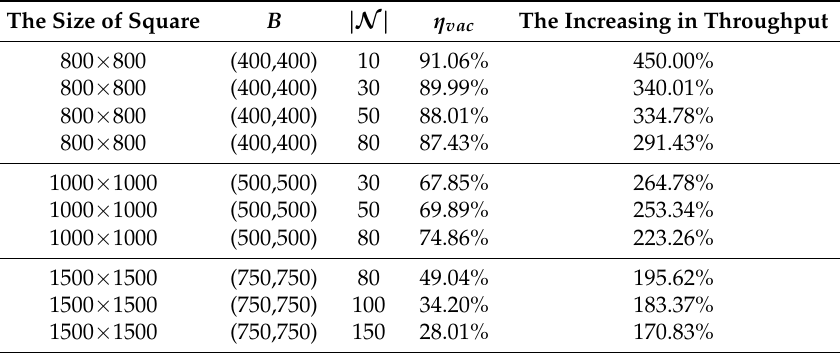
Table 3. The numerical results in the four different